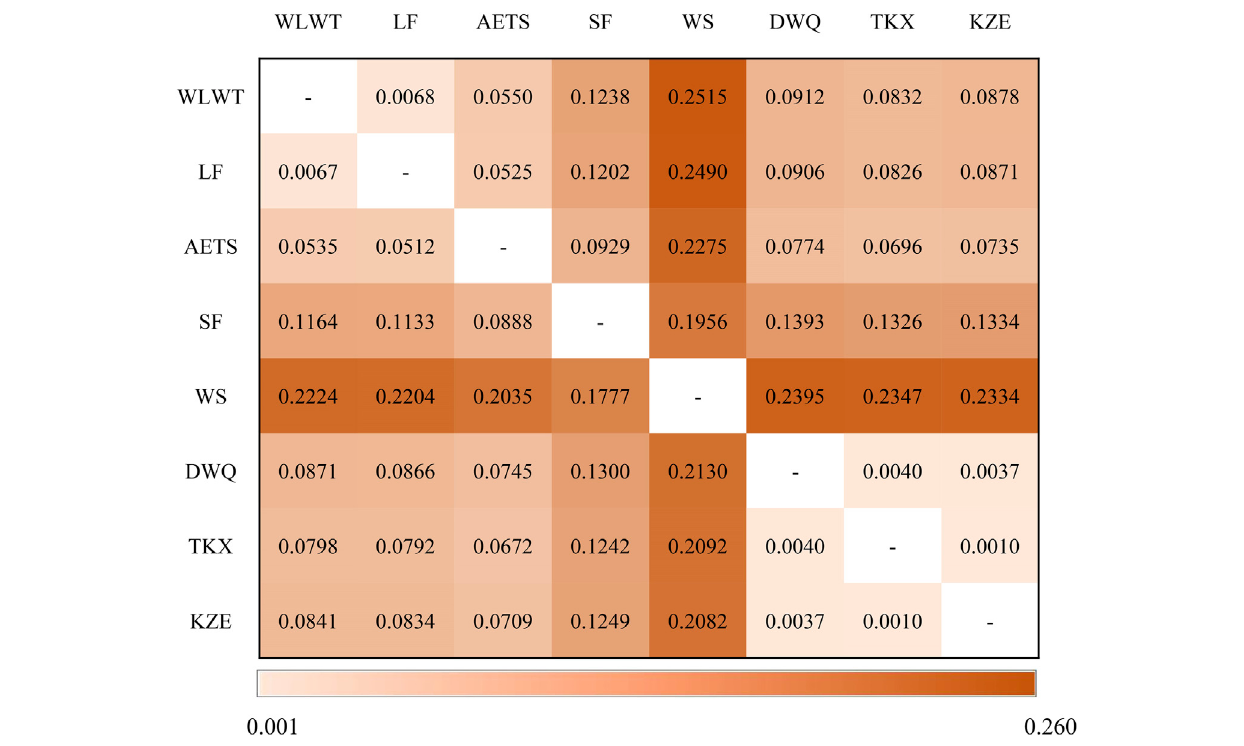
FIGURE 4 | Genetic differentiation F ST value (below diagonal) and genetic distance (above